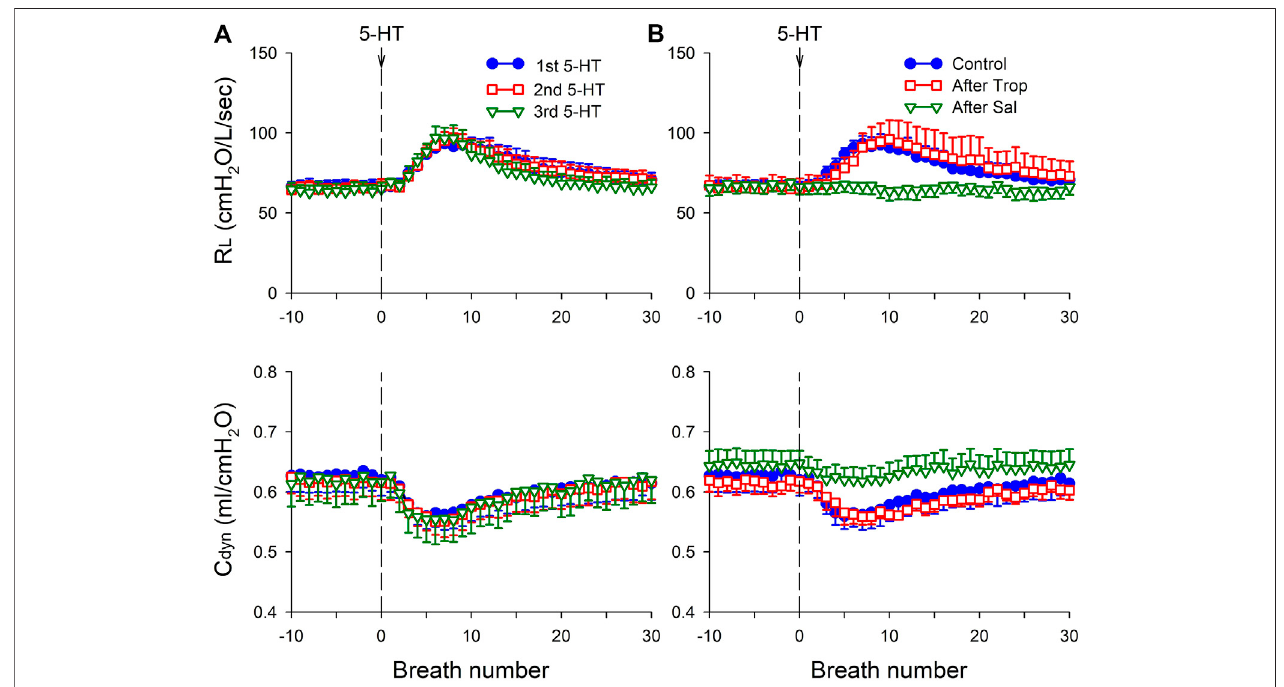
FIGURE 3 | (A) Group data illustrating the reproducibility of the effects of i. v. injection of 5-HT (16 μ g/kg) on total pulmonary resistance (R L ) and dynamic lung compliance (C dyn ) in eight anesthetized, vagotomized, open-chest, and mechanically ventilated rats; at least 15 min elapsed between two injections of 5-HT. (B) ResponsesofR L andC dyn tothe5-HTinjections(16 μ g/kg)before,15 minafterpretreatmentwithTrop(15 μ g/kg),and10 minafterpretreatmentwithSal(0.5 mg/kg)in the same eight rats as in